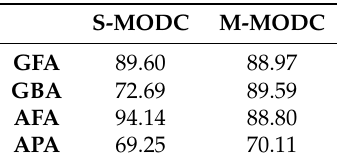
Table 10. S-MODC x M-MODC